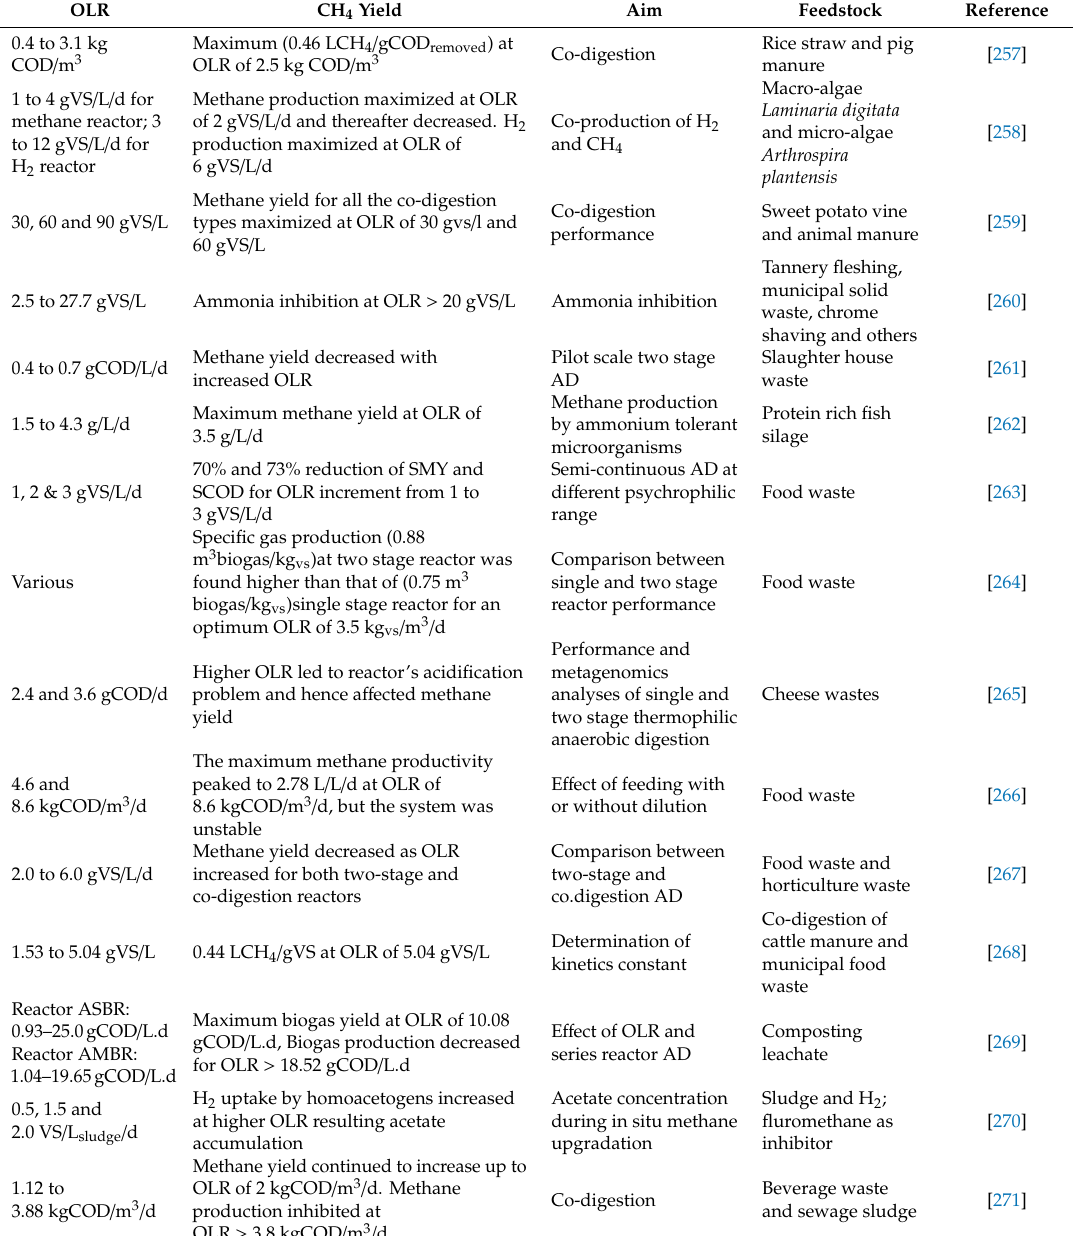
Table 5. A range of OLR variations used in selected recent publications on anaerobic digestion. OLR CH 4 Yield Aim Feedstock